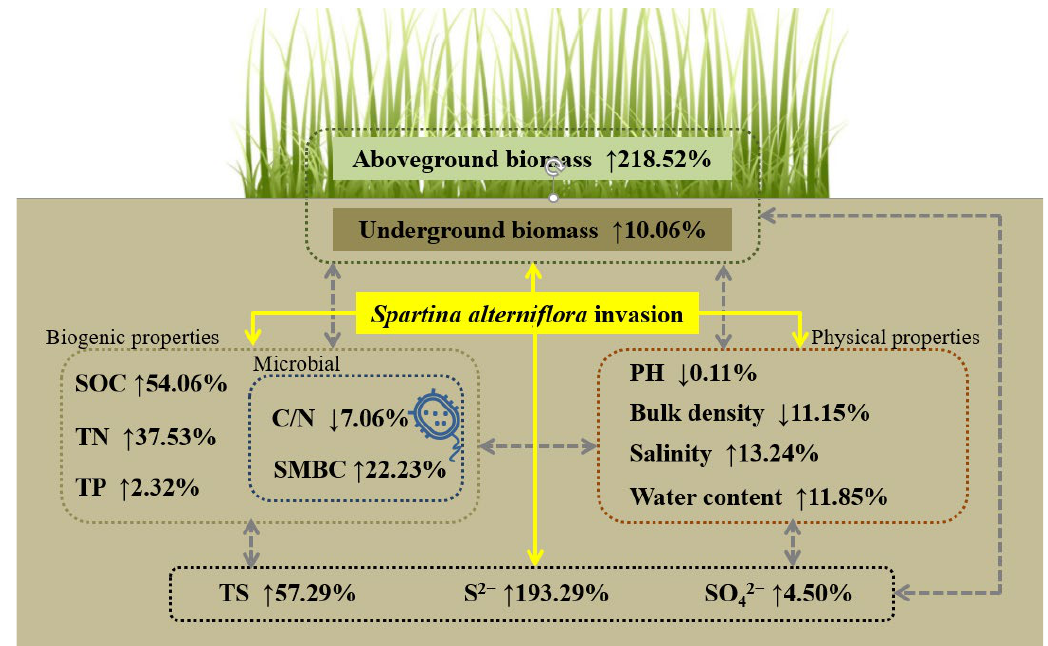
Figure 6. A conceptual framework illustrating how S. alterniflora invasion affects soil sulfur contents and other soil properties. “ ↑ ” means positive effect; “ ↓ ” means negative effect. Solid and dashed arrows, respectively, represent direct effects of S. alterniflora invasion and indirect effects speculated. SOC, soil organic carbon; TN, total nitrogen; TP, total phosphorus; SMBC, soil microbial biomass carbon; TS, total sulfur.